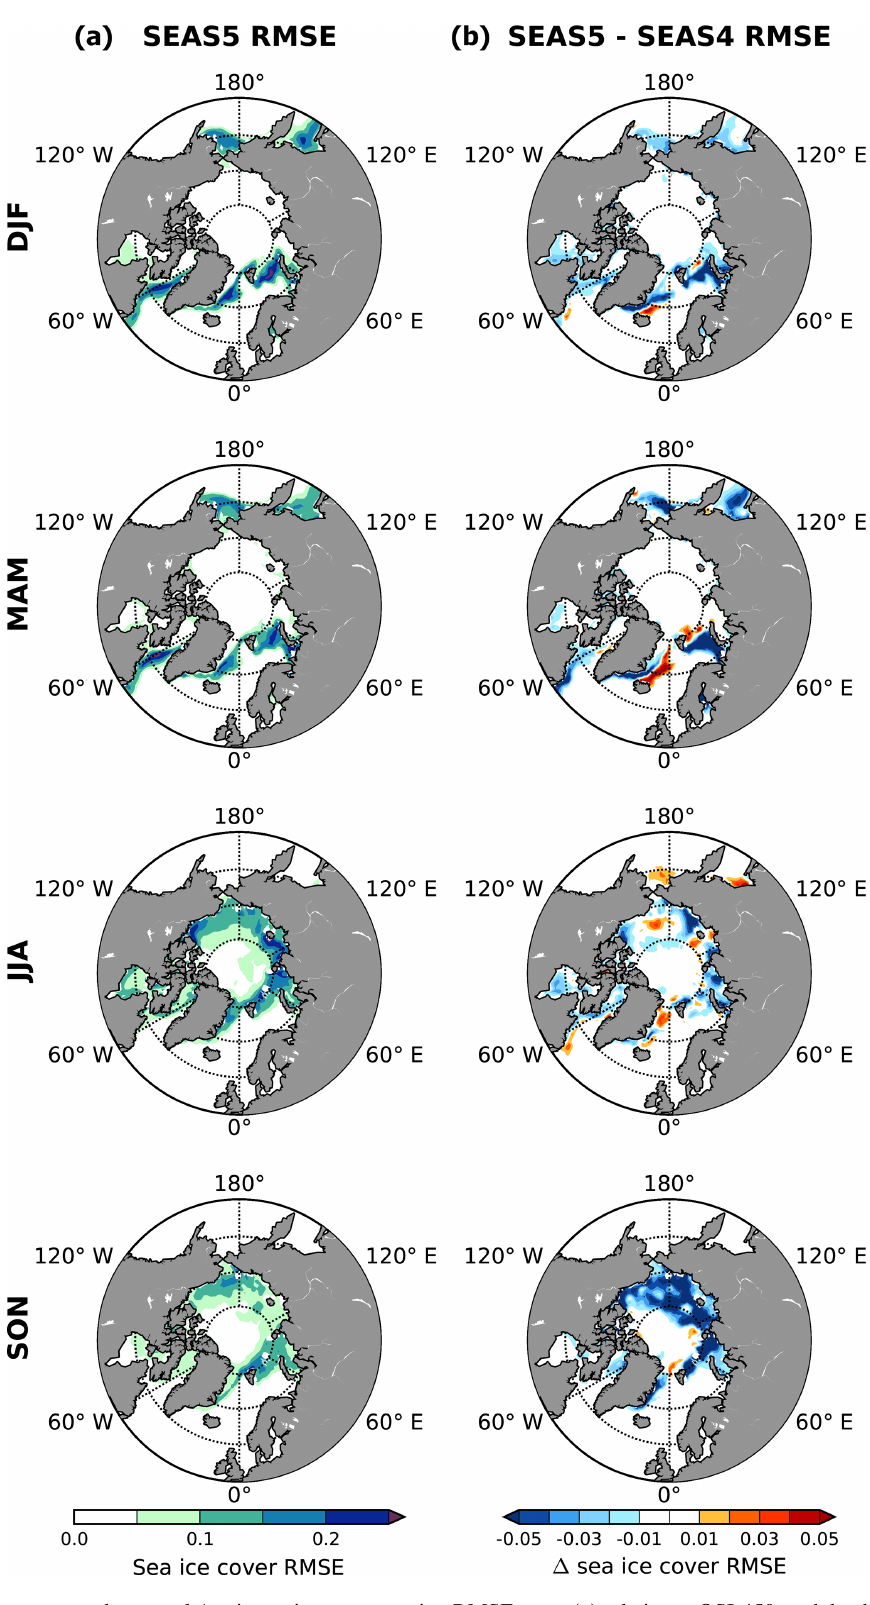
Figure 16. SEAS5 bias-corrected seasonal Arctic sea-ice concentration RMSE maps (a) relative to OSI-450, and the difference compared to SEAS4 (b) at 1 month lead time. Twenty-five ensemble members are used from each forecast system. Due to gaps in the satellite record, a small number of seasons had to be excluded from this analysis (see Sect. 3.2 for